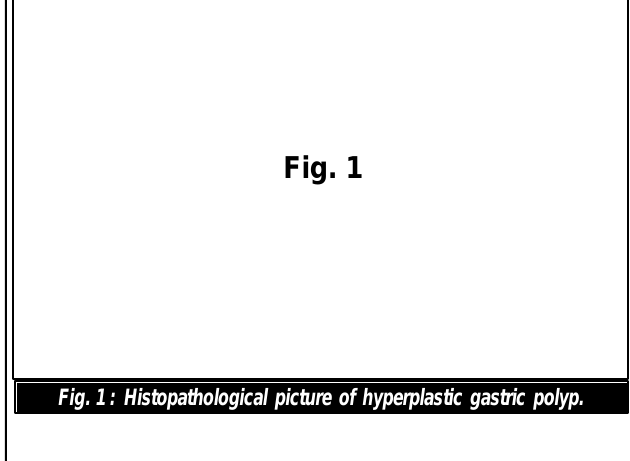
Fig. 1 : Histopathological picture of hyperplastic gastric polyp.